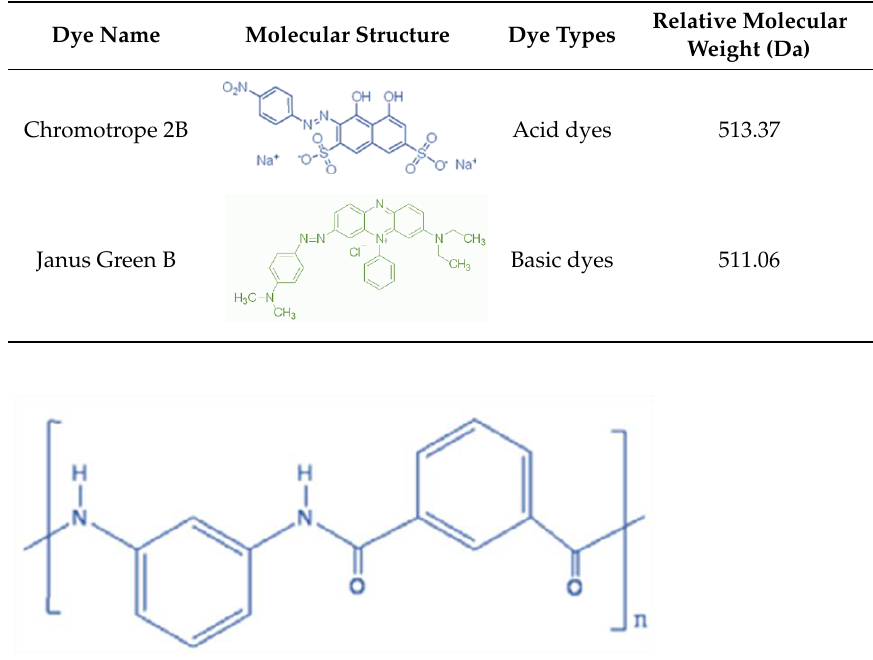
Figure 1. Chemical structure of PMIA. Table 1. Characteristics of the Chromotrope 2B and Janus Green B.